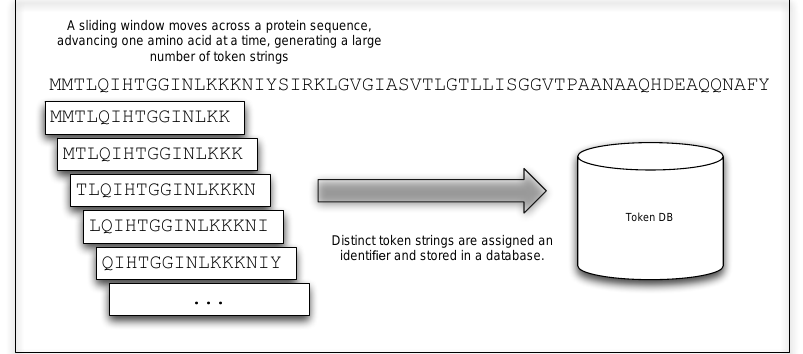
Figure 2: Generating the protein token database. The individual protein sequences in a GenBank entry are first split into a series of overlapping fragments (tokens). The details of each token, including the position within a particular protein and the taxon from which that protein is derived are then recorded in a database. The tokens are used to specify the binding sites for diagnostic